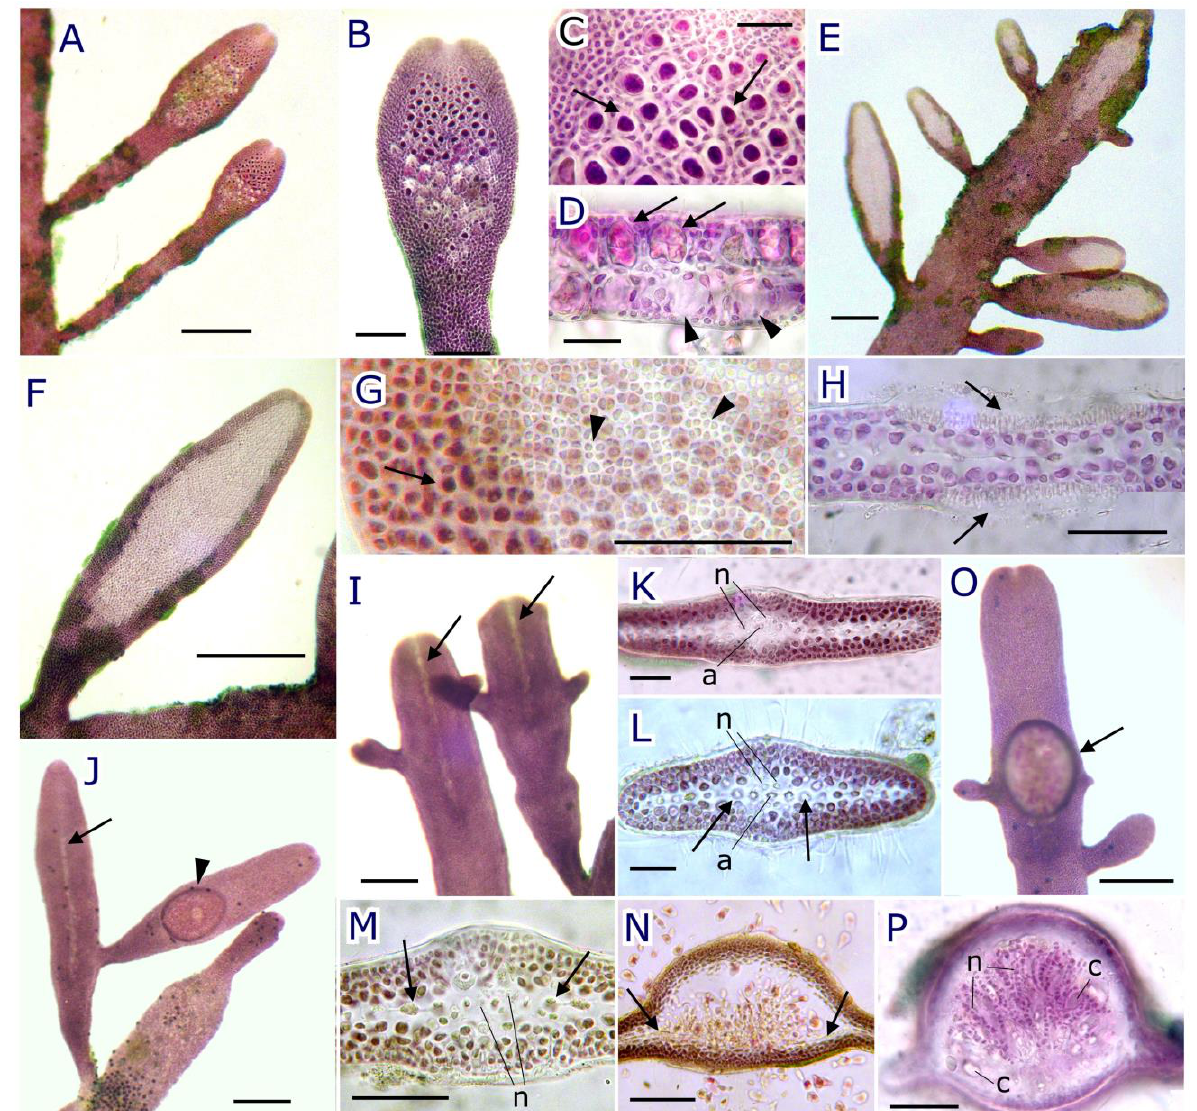
Figure 6. Pterocladiella canariensis sp. nov. ( A ) Two terminal tetrasporangial sori in lateral branchlets; ( B ) tetrasporangial sorus with sterile margin and tetrasporangia arranged in V-shaped rows; ( C ) surface view of rows of tetrasporangia (arrows) surrounded by outer cortical cells; ( D ) transverse section of an erect axis through a tetrasporangial sorus showing cruciate to decussately divided tetrasporangia (arrows) and empty cavities after tetrasporangia release (arrowheads); ( E ) sperma- tangial sori terminal in an erect axis and on shorth lateral branchlets; ( F ) spermatangial sorus with sterile margin; ( G ) surface view of spermatangial sorus showing pigmented outer cortical cells of the sterile margin (arrow) and densely packed hyaline spermatangia (arrowheads); ( H ) transverse section through a spermatangial sorus showing spermatangia arranged on both sides of the fertile branch (arrows); ( I ) two terminal fertile carpogonial axes showing longitudinal hyaline grooves starting from the apex (arrows); ( J ) branchlet with longitudinal hyaline groove (arrow) with lateral branch in which a cystocarp has developed (arrowhead); ( K – N ) successive phases of development of the cystocarp showing rounded nutritive cells (n) on both sides of the axial cell (a) and the central row (arrows) and the placental tissue attached to the cystocarp floor; ( O ) surface view of a mature cystocarp (arrow); ( P ) transverse section through a mature cystocarp showing the basal arrange- ment of placental tissue and the cavity occupied by nutritive filaments (n) and gonimoblastic fila- ments with terminal carposporangia (c). Scale bar: 300 µm ( A , E , F , I , J , O ), 100 µm ( B , N , P ), and 50 µm ( C , D , G , H , K – M ).